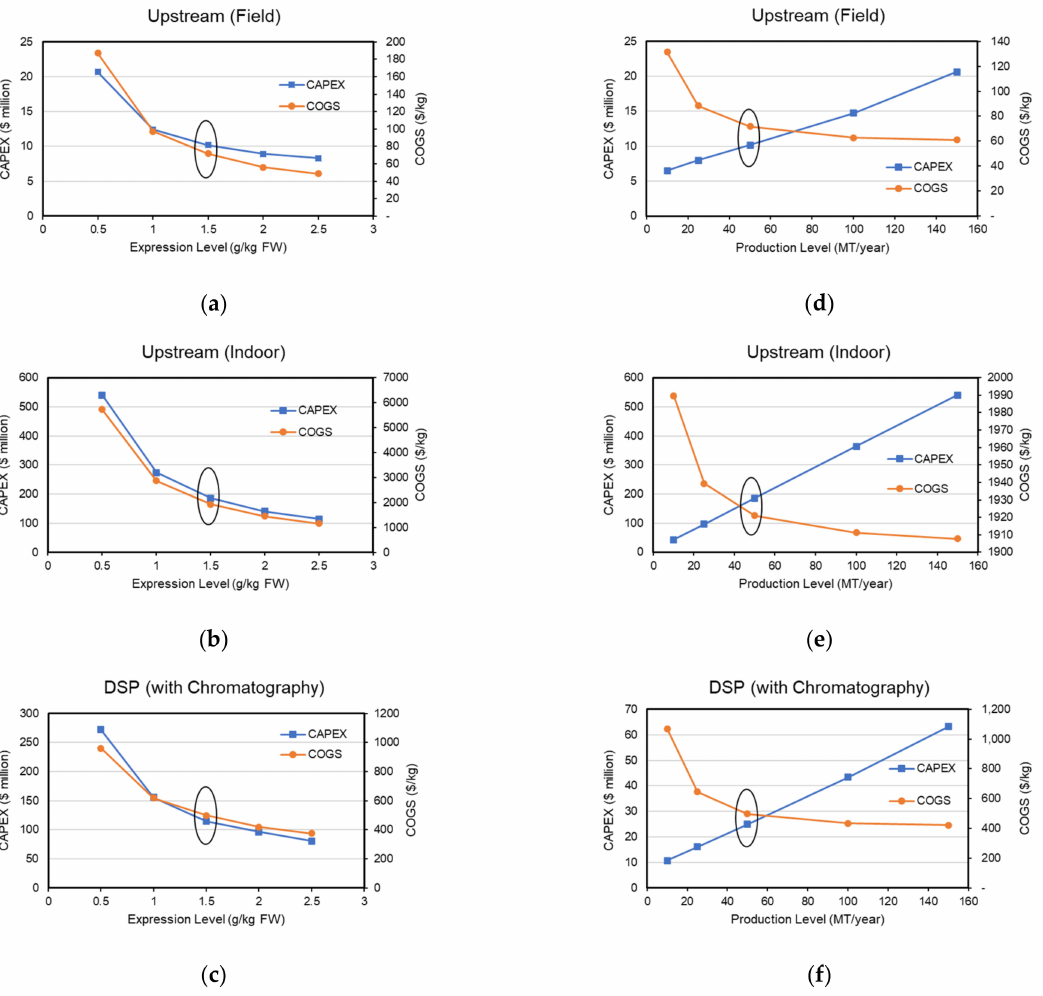
Figure 4. Scenario analysis varying expression level effects on CAPEX and COGS for ( a ) field upstream transgenic facility, ( b ) indoor upstream transgenic facility, ( c ) base case downstream processing facility. Scenario analysis varying production level effects on CAPEX and COGS for ( d ) field upstream transgenic facility, ( e ) indoor upstream transgenic facility, ( f ) base case downstream processing facility. Depreciation costs are excluded. Base case values are circled. CAPEX, Capital expenditure; COGS, cost of goods sold; DSP, downstream processing; FW, fresh